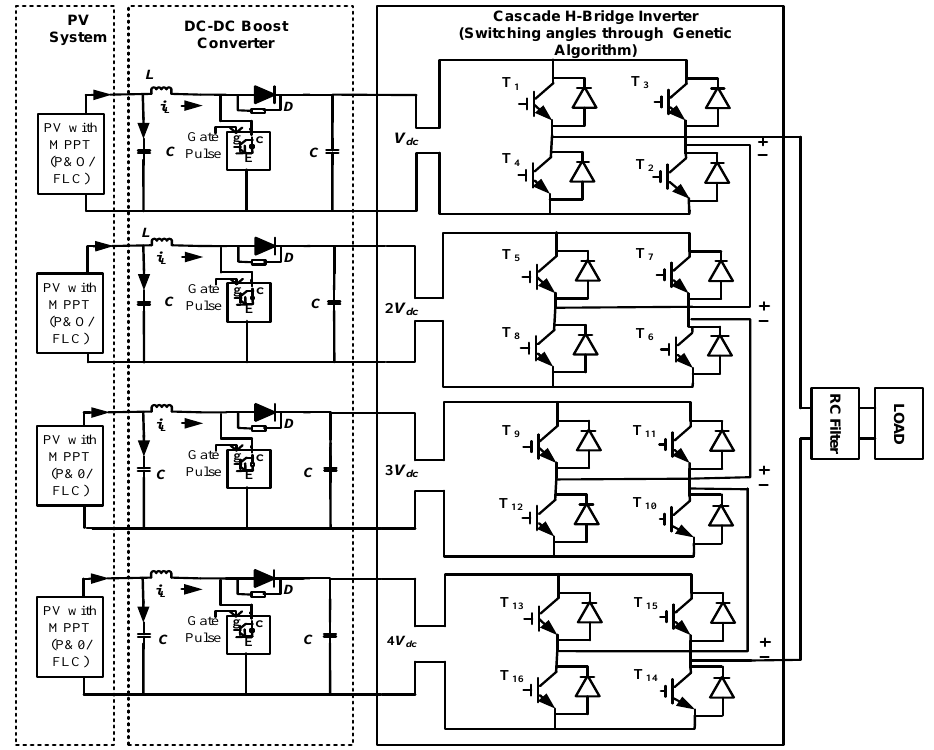
Figure 7. Single phase 9-level CHB-MLI configuration integrated with PV panel.